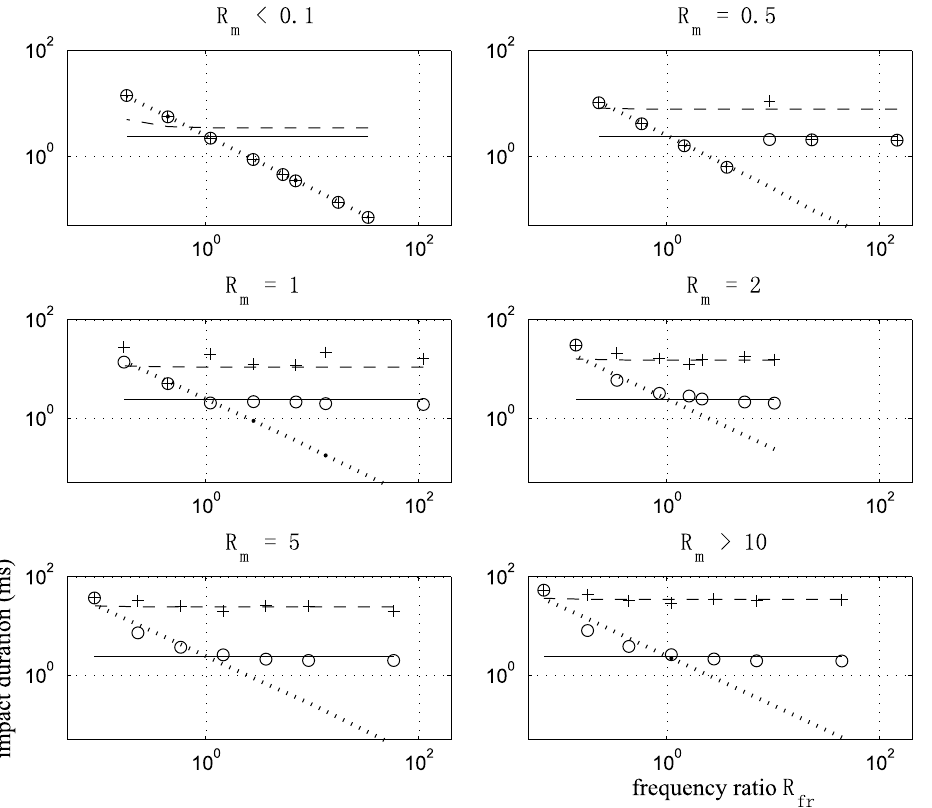
◦ Fig. 4. Impact duration sensibility: “ ”: fi rst impact duration; “ + ": total impact duration; solid line: 1 / 2 T AO 1 ; doted line: 1 / 2 T AAO ; dashed line: T QS . T QS corresponds to a quasi-static response of the beam which is modelled as a massless spring characterized by its static stiffness k 0